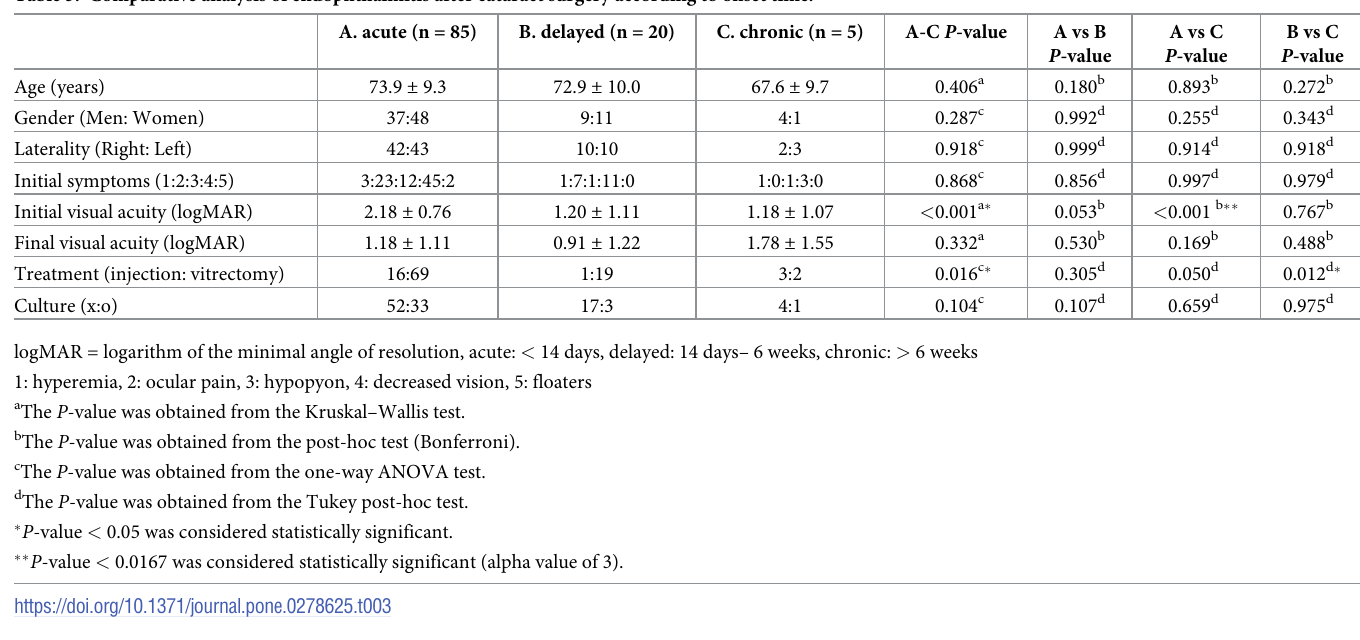
Table 3. Comparative analysis of endophthalmitis after cataract surgery according to onset